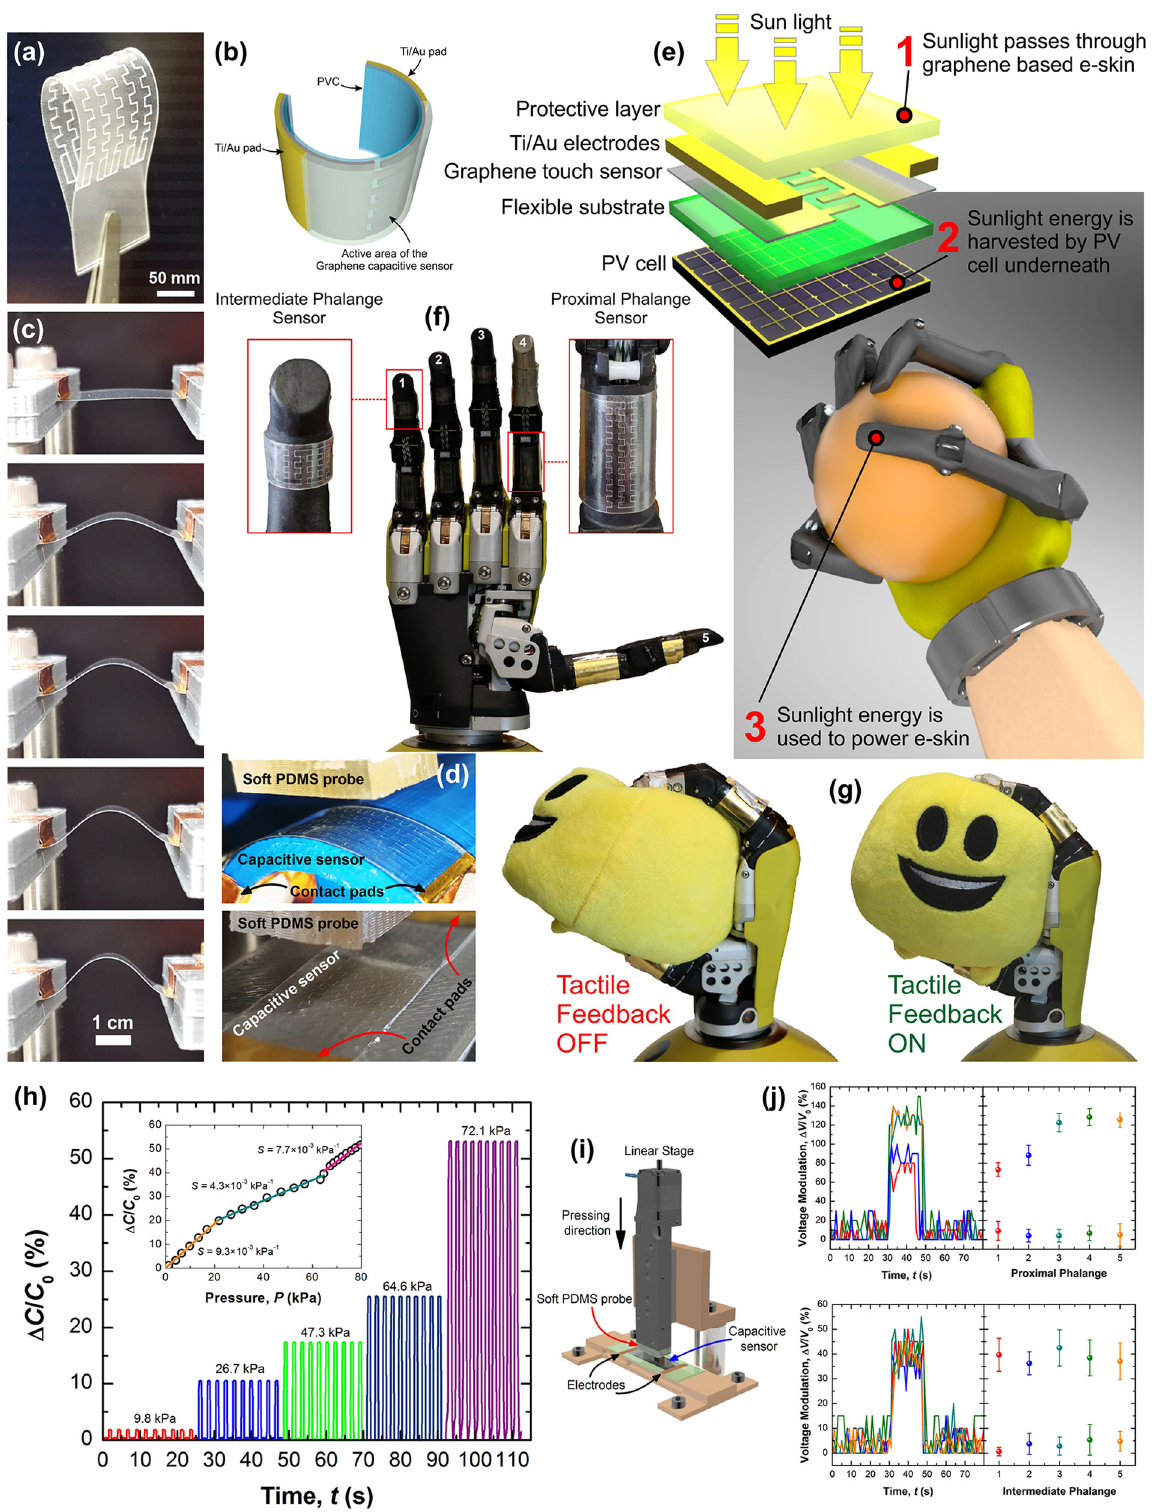
Fig. 8 Touch sensitive e -skin powered by light energy. a Photograph and b 3D schema of a fl exible graphene capacitive touch sensor. c Dynamic and d static bending characterization of sensors. e 3D schema of self-powered e -skin structure. f e -skin integrated onto a robotic hand. g Self-powered e -skin used as tactile feedback for a robotic hand. h Touch sensor response vs. applied pressure. i Schema of the characterization setup. j Response from e -skin integrated on a robotic limb (error bars correspond to a series of 10 devices tested up to fi ve times under the same conditions). Reprinted with permission from García Núñez et al. 1 Copyright © 2017, John Wiley and